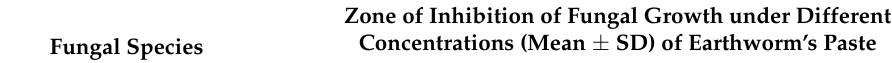
Table 4. Antifungal activity of crude earthworm paste through the Disc assay method (adopted from Vasanthi et al. 2013) [57].